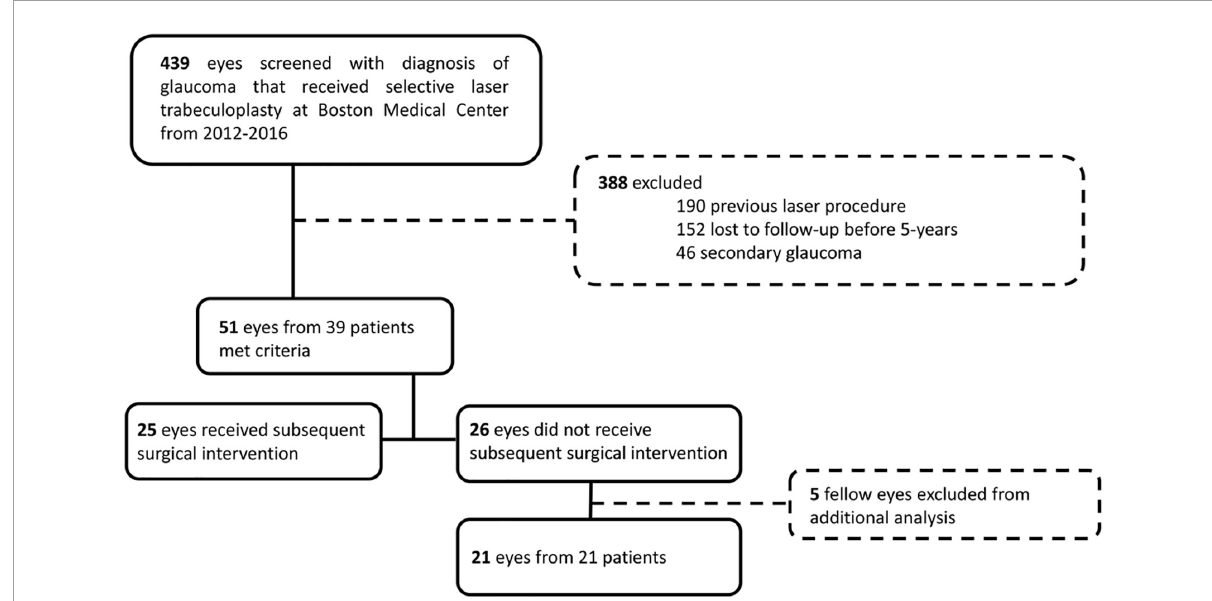
FIGURE1 CONSORT diagram for retrospective chart review. We retrospectively screened 439 charts of eyes with diagnosis of glaucoma that received SLT at Boston Medical Center from 2012 to 2016. We excluded 388 eyes that had a previous laser procedure, were lost to follow-up within 5-year, or had secondary open-angle glaucoma or angle-closure glaucoma. We included 51 eyes, who had sufficient 5-year follow-up, of which 25 received subsequent surgical intervention and 26 did not. For analysis of the outcome measures of the patients that did not receive subsequent surgical intervention, we excluded fellow eyes to only analyze one eye per